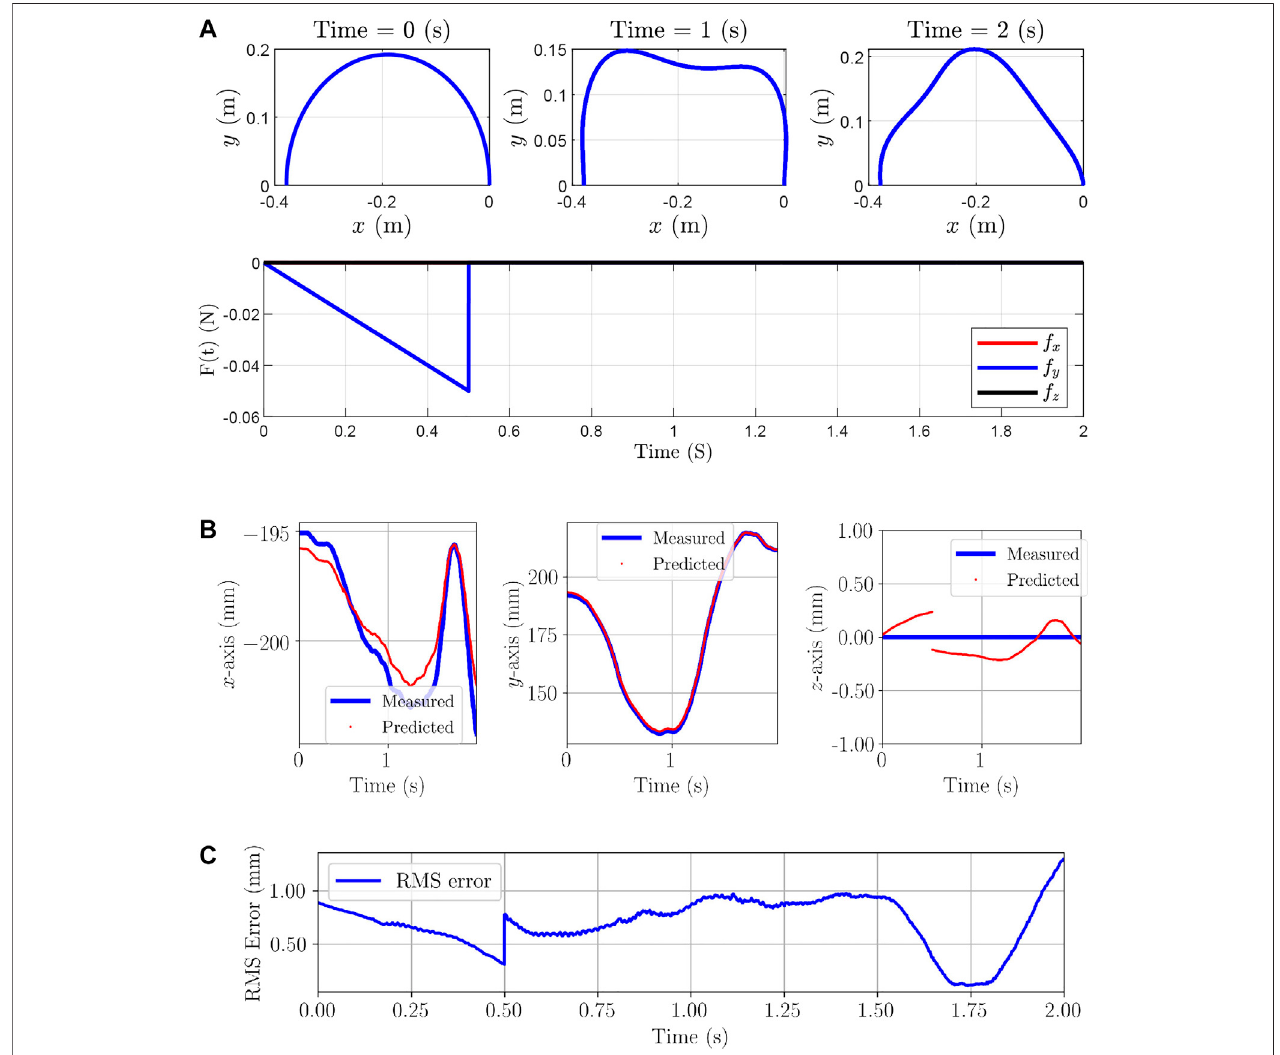
FIGURE 8 | Third simulation example: (A) : Initial, Time-evolved con fi gurations and forces applied on the rod. Positions of the middle node, where the force is applied, are measured and predicted. (B) : Measured position calculated from analytical dynamic model and predicted by the proposed RNN-based model in the x , y , and z -axes are given. (C) RMS error considering all the